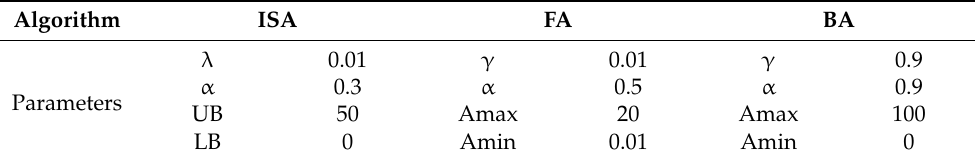
Table 1. Algorithms’ parameters.